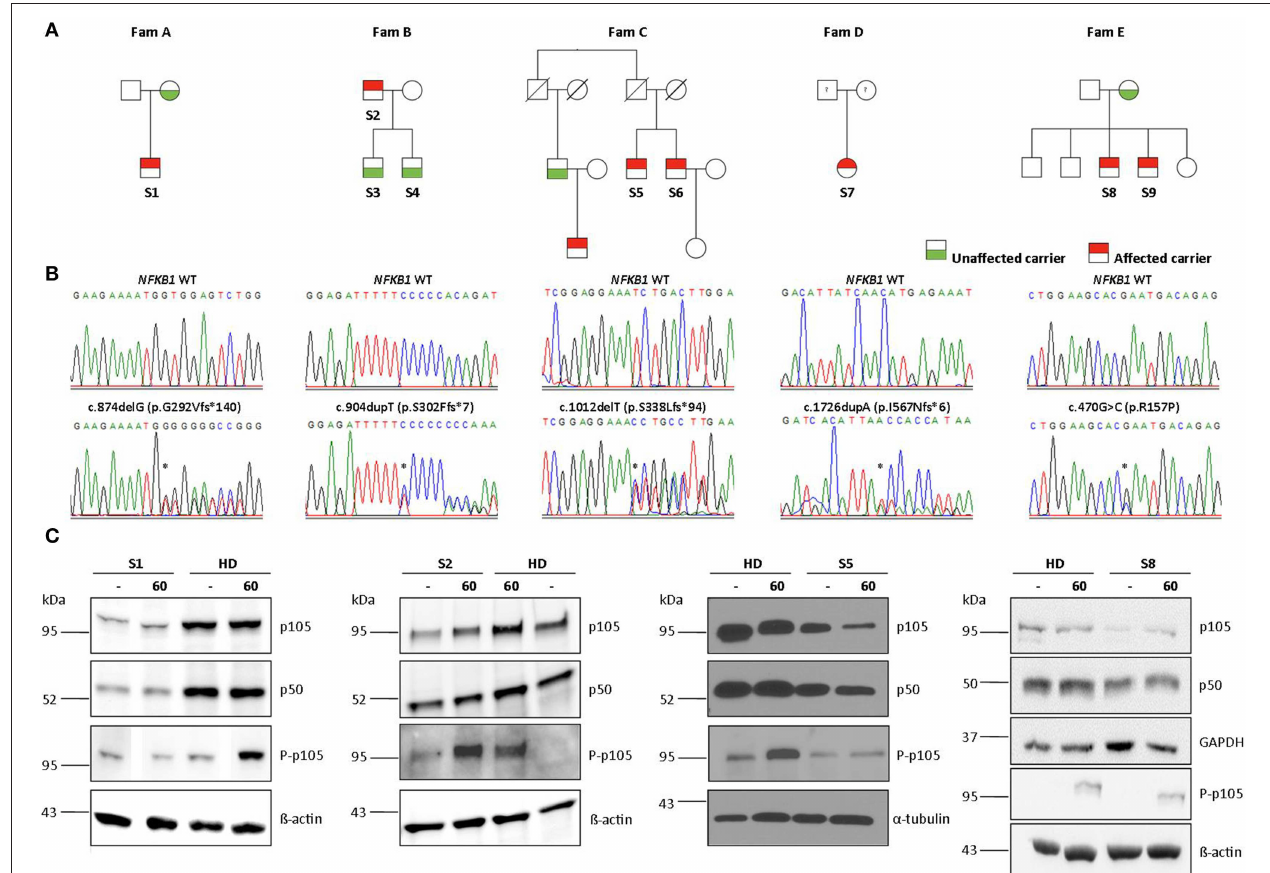
FIGURE 1 | Monoallelic NFKB1 mutations result in NFKB1 haploinsufficiency. (A) Segregation of NFKB1 variants were analyzed by sequencing of genomic PCR products and revealed an autosomal-dominant inheritance in families with incomplete clinical penetrance. (B) Sequencing of genomic PCR products result in chromatograms of haploinsufficiency mutations, precursor-skipping mutation, and missense mutation of wild type (WT) and affected individuals. (C) PBMCs from affected individuals and healthy donors (HD) were stimulated with PMA plus ionomycin for 60min as indicated. PBMC lysates were analyzed for amounts of p105 and p50 and for phosphorylated p105 (Ser933, P-p105) by Immunoblotting. ß-actin, α -tubulin, and GAPDH were used as loading controls. Individual lanes of WB for S1 and S8 have ben reordered for publishing purposes. Mutations are marked with